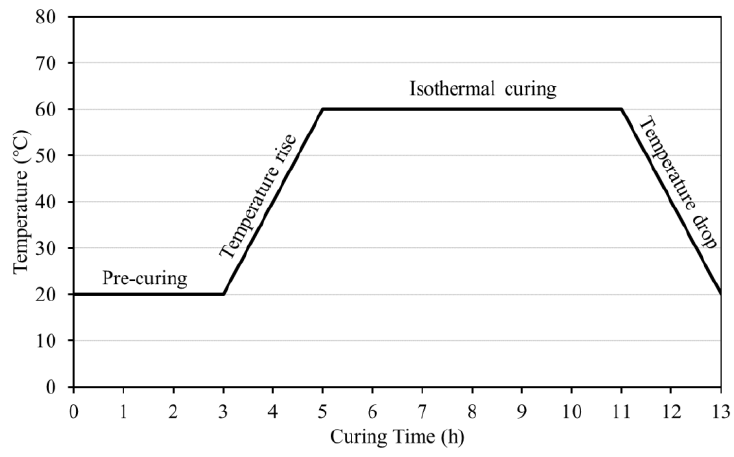
Figure 4. Steam curing method.